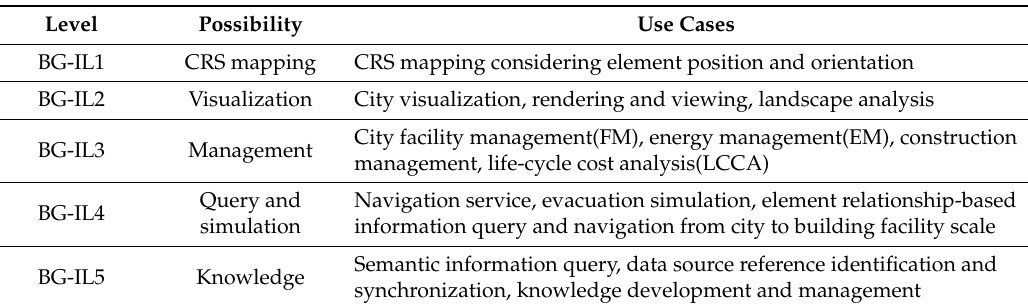
Table 10. BG-IL use-case